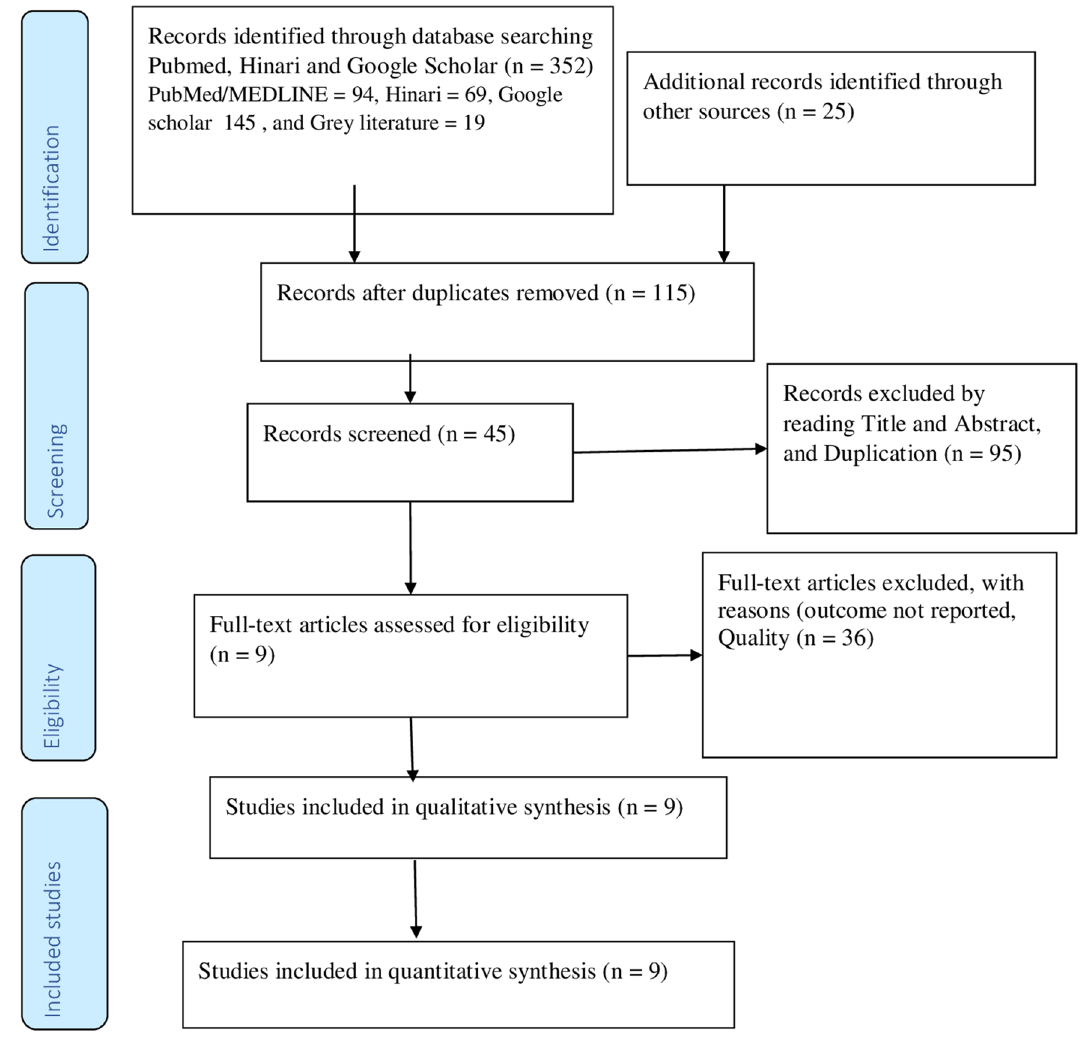
Figure 1. PRISMA flow diagram of article selection for systematic review and meta-analysis of magnitude of undiagnosed DM and associated factors in Ethiopia, 2021.